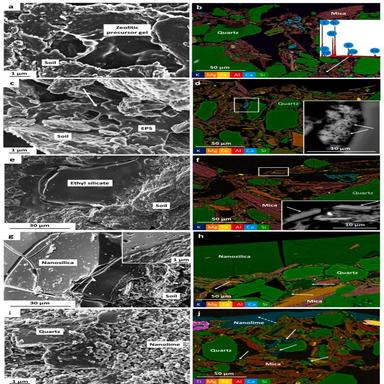
FESEM secondary electron images of surface fragments (left panels) and elemental maps of cross-sections (right panels, the treated surface always being aligned along the top of the image) of earthen mock-ups treated with: a) and b) KOH, showing the formation of a gel-like phase, probably an amorphous zeolitic precursor (EDS analysis in inset); c) and d) BAC, showing EPS bridging mineral grains (white arrow) and scarce formation of cement containing calcified bacteria cells (BSE image in inset, white arrows)